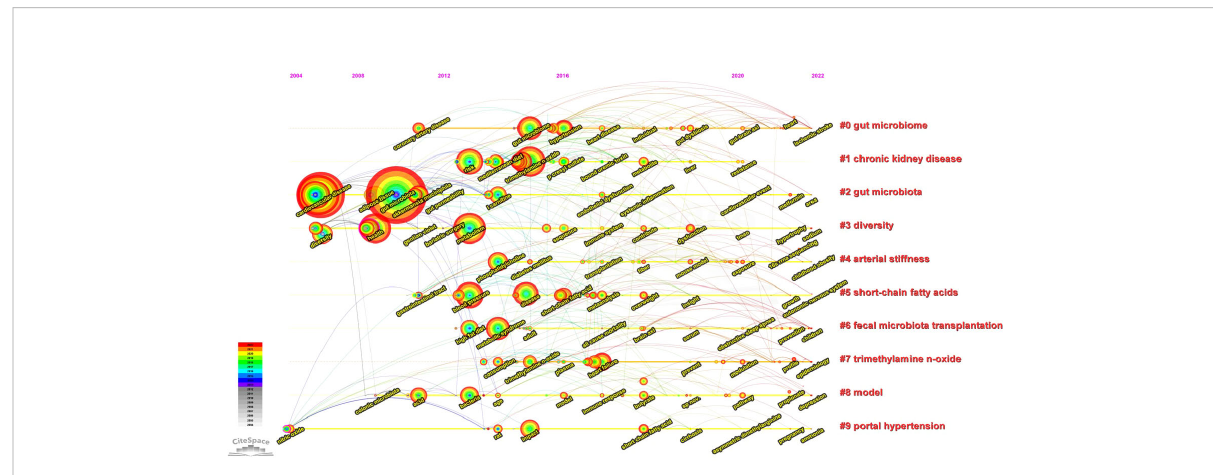
FIGURE 7 Visualization map of timeline viewer of keywords from the top ten clusters in this fi eld by